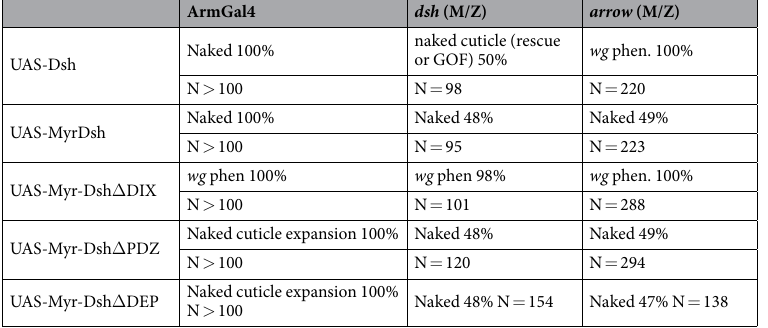
Table 1. Quantification of embryonic phenotypes. Column (ArmGal4) represents the phenotype of a simple Gal4 driver to UAS construct cross where all embryos are expected to overexpress Dsh. Column ( arr ) represents embryos where all maternal arr is removed, paternally rescued embryos are removed by GFP selection and 50% of embryos are expected to express Dsh. Therefore, ‘50% naked cuticle’ corresponds to full suppression. Column ( dsh ) represents embryos where all maternal endogenous Dsh is removed, paternally rescued embryos are ignored based on y + , and 50% of embryos are expected to express UAS-Dsh. Therefore, ‘50% naked cuticle’ corresponds to full rescue. The naked phenotype is defined as fewer denticles than in wild type, but not necessarily that all denticles are